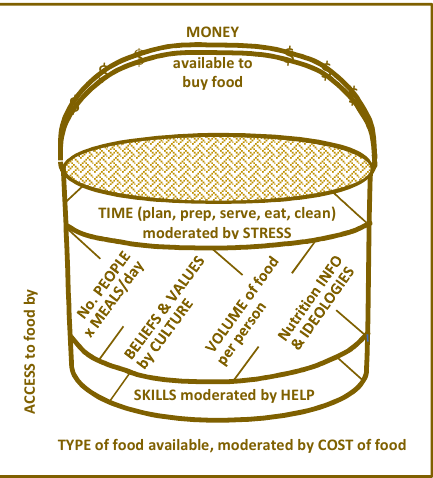
Figure 1. Kete (basket) of factors influencing food provisioning aimed towards having happy children.